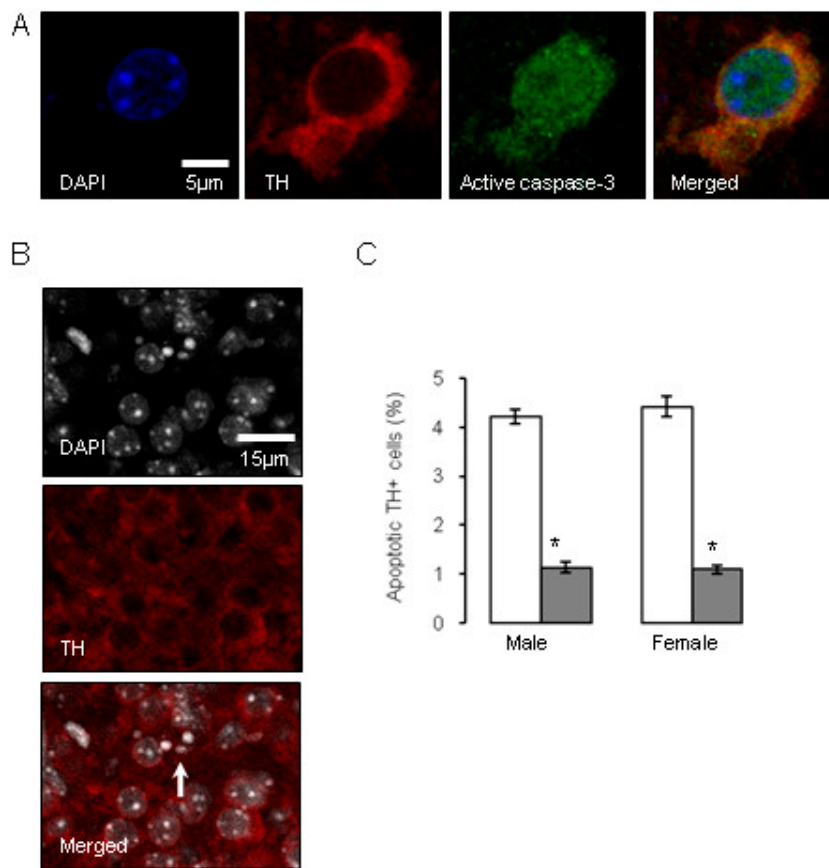
Figure 4. Influence of antenatal glucocorticoid treatment (AGT) on apoptosis in dopaminergic neurons (TH-IR cells) on postnatal day 2 (P2). A proportion of murine TH-IR cells undergo apoptotic changes on postnatal day P2, as identified by immunostaining for activated caspase-3 ( A ), or by the presence of nuclear condensation ( B ). The white arrow indicates an example of pronounced nuclear condensation. TH-IR cell apoptosis was quantified in the combined SNc and VTA at postnatal day P2 in male and female mice ( C ) treated with dexamethasone via the maternal drinking water antenatally on embryonic days 16–19 ( 0.5 µg/mL), and compared to the control offspring of dams receiving normal drinking water ( ). Data are means ± SEM, n = 6 animals per treatment group. * Indicates a significant effect of treatment, p < 0.05 for dexamethasone treated vs. control animals.